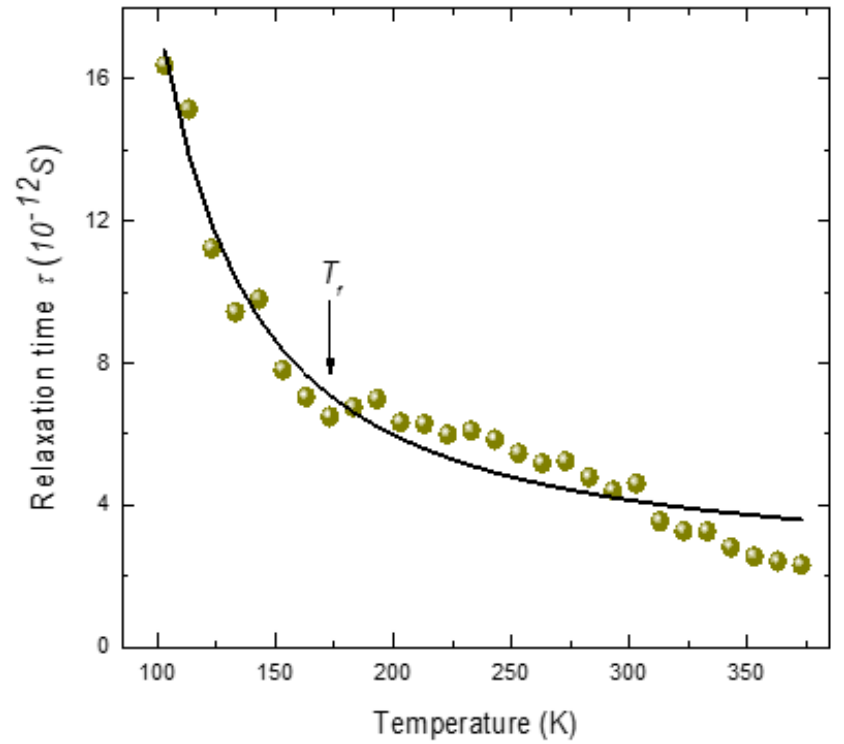
Figure 6. Fit of the Arrhenius law (solid line) with the relaxation time τ (solid sphere) (Reprinted with kind permission from Ref. [41]. 2015, the European Physical Journal (EPJ)).